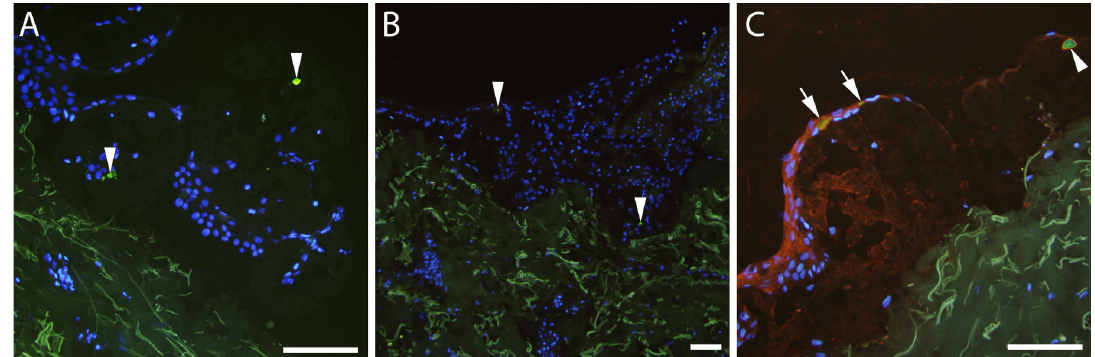
Fig 5. Transplantation of CFSE-stained melanocytes to ex vivo wounds. 5(6) carboxyfluorescein-N-hydroxysuccinimidyl ester (CFSE)-stained melanocytes (arrowheads) on microcarriers in an ex vivo wound seven (A) and 14 (B) days post transplantation (green staining). (C) Wound edge seven days post transplantation of co-cultured CFSE-stained keratinocytes and melanocytes. Sections were stained with keratinocyte-specific cytokeratin antibodies; double stained keratinocytes are indicated by arrows, green fluorescent melanocytes by arrowheads. Scale bars = 100 μ